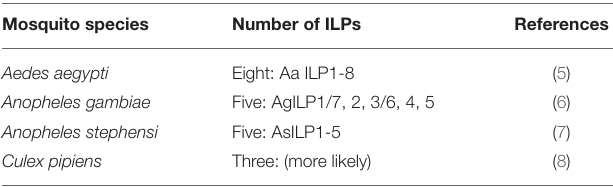
TABLE 1 | Number of insulin-like peptides identified in different mosquito genera and species. Mosquito